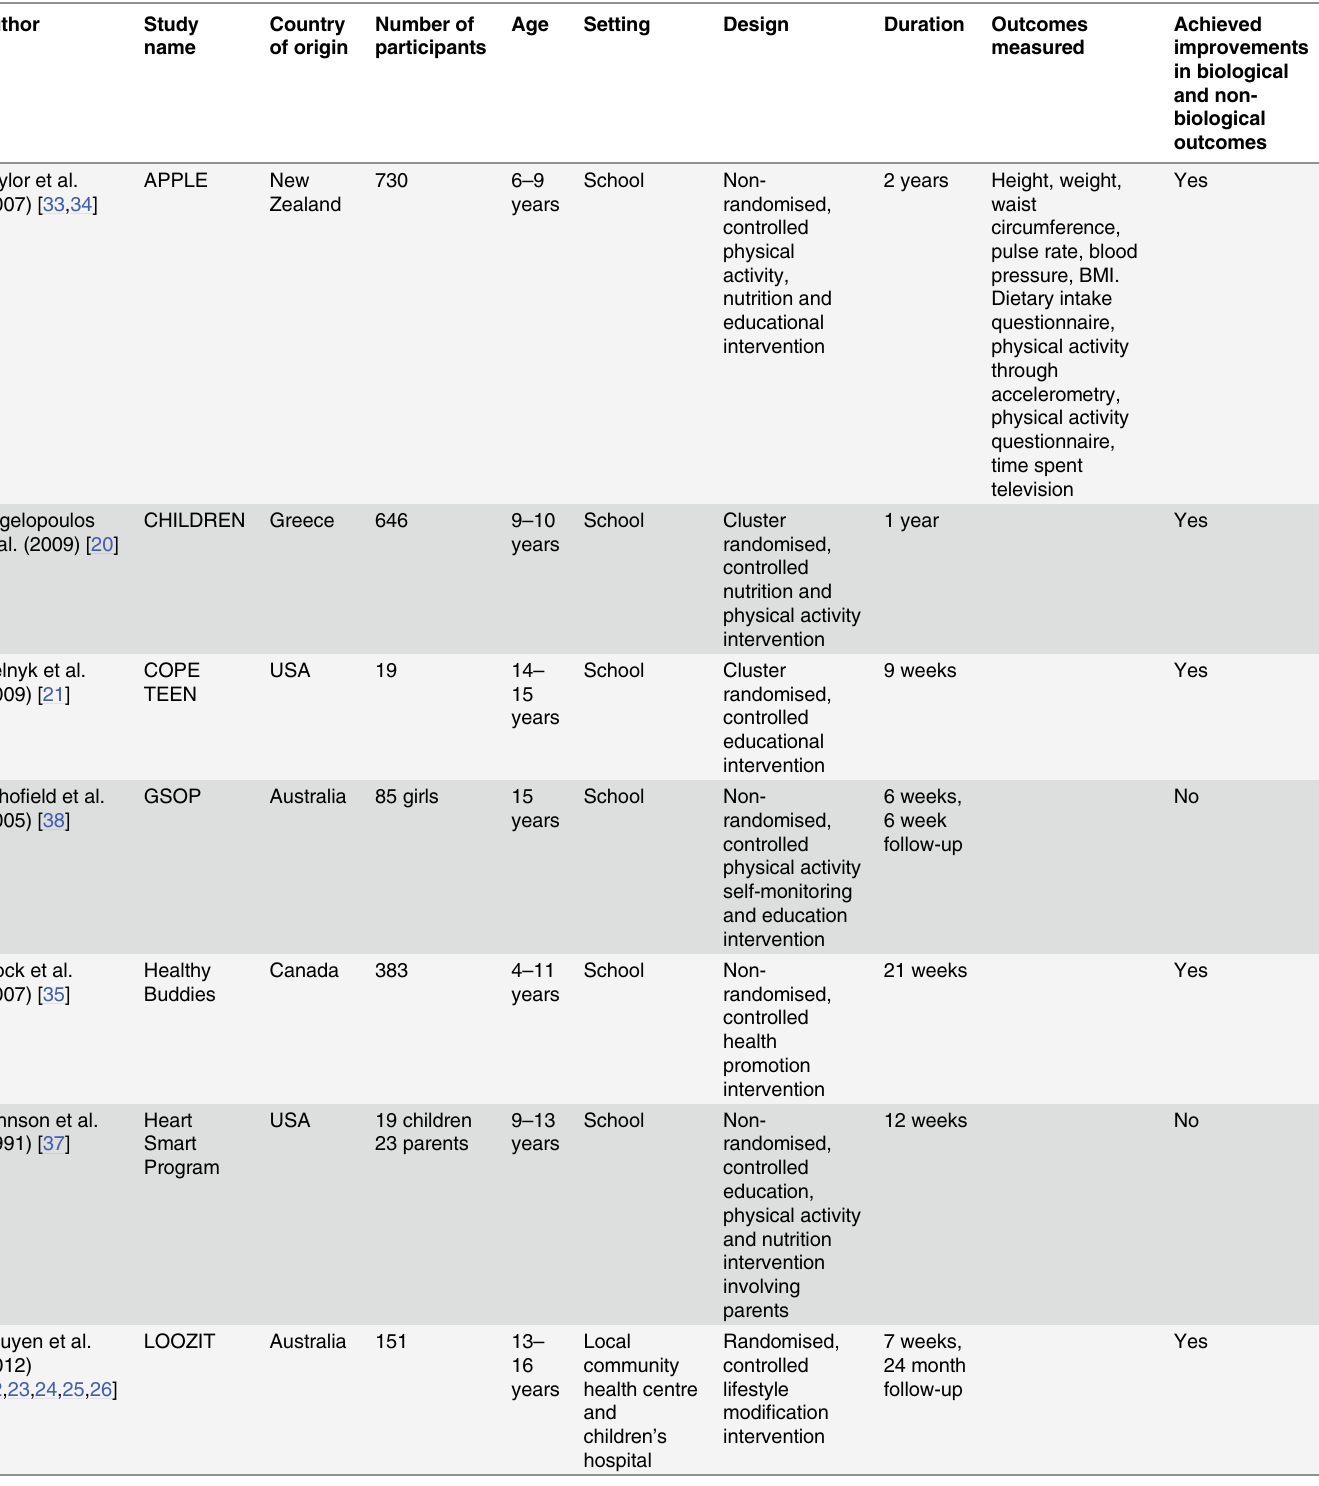
Table 1. Characteristics of included